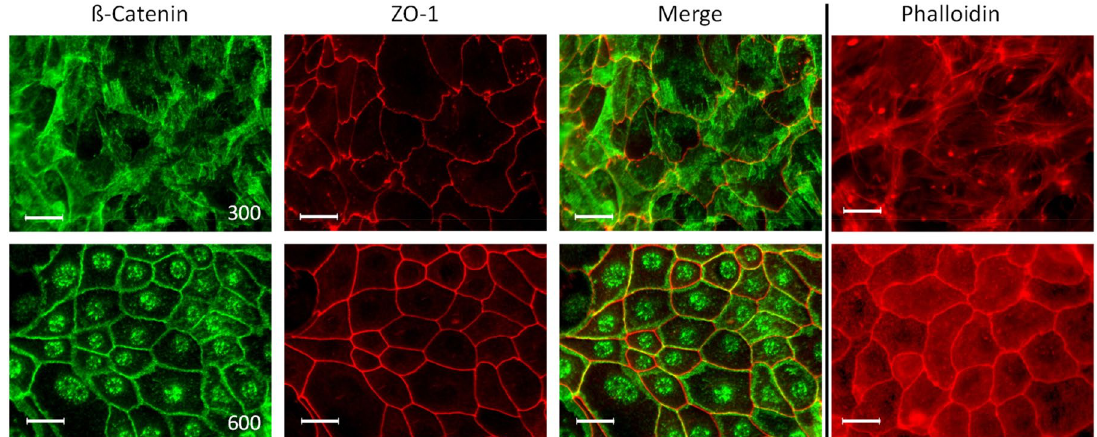
Figure 3. Osmolality has an impact on cell morphology. IMCD-cells were cultivated at 300 (upper panel) and 600 mosmol/kg (lower panel) and staining for β-catenin, Zo-1 and actin was performed using specific antibodies or phalloidin (for actin) respectively. Secondary Alexa-488 or Alexa-568 labeled antibodies or Alexa- 568 labeled phalloidin were used for visualization. Scale bar = 20